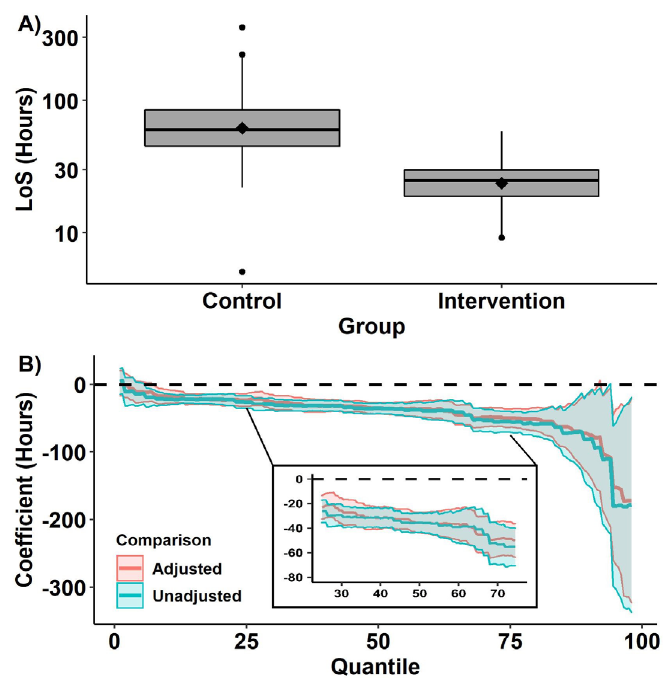
Figure 1. A) A box and whisker plot depicting length of stay as a function of intervention group. The solid lines within the boxes depict the median for each group and the diamonds within the boxes depict the means for each group. Note that the data are presented on a log10 scale. B) The results of the quantile regressions evaluating the association between the protocols and length of stay. The solid lines depict the difference between the intervention and control groups (eg, the median/50th percentile for the intervention group was approximately 35 hours shorter than for the control group; however, the 75th percentile was approximately 55 hours shorter for the intervention group than for the control group). Negative coefficients indicate that the intervention group had reduced lengths of stay relative to the control group. Shaded regions depict the 95% confidence intervals. The inset section of panel B highlights the change in cost between the 25th and 75th percentiles LOS , length of